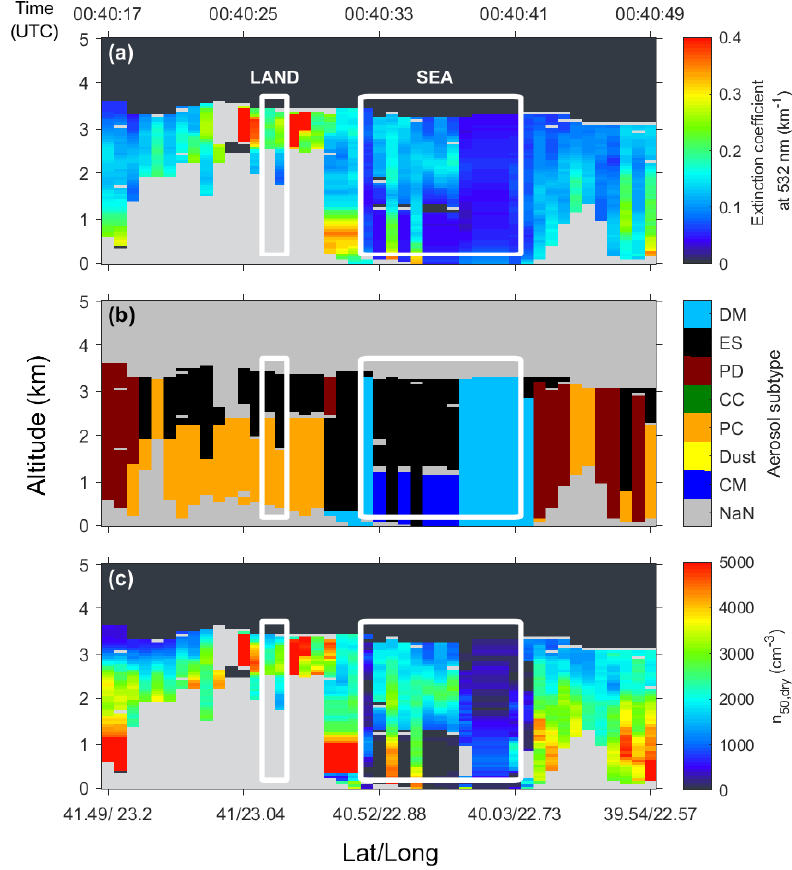
Figure 6. Plot of extinction coefficient (a) , aerosol subtype mask (b) , and the OMCAM-estimated n 50,dry concentrations (c) for a CALIPSO overpass over the Thessaloniki region of northern Greece on 9 September 2011. The white lines mark the land (40.85–40.95 ◦ N) and sea (40–40.6 ◦ N) regions for which the in situ observations at different altitudes are provided by Tsekeri et al. (2017). The grey colour represents invalid values (NaN). Abbreviations: CM – clean marine, PC – polluted continental, CC – clean continental, PD – polluted dust, ES – elevated smoke, and DM – dusty marine.